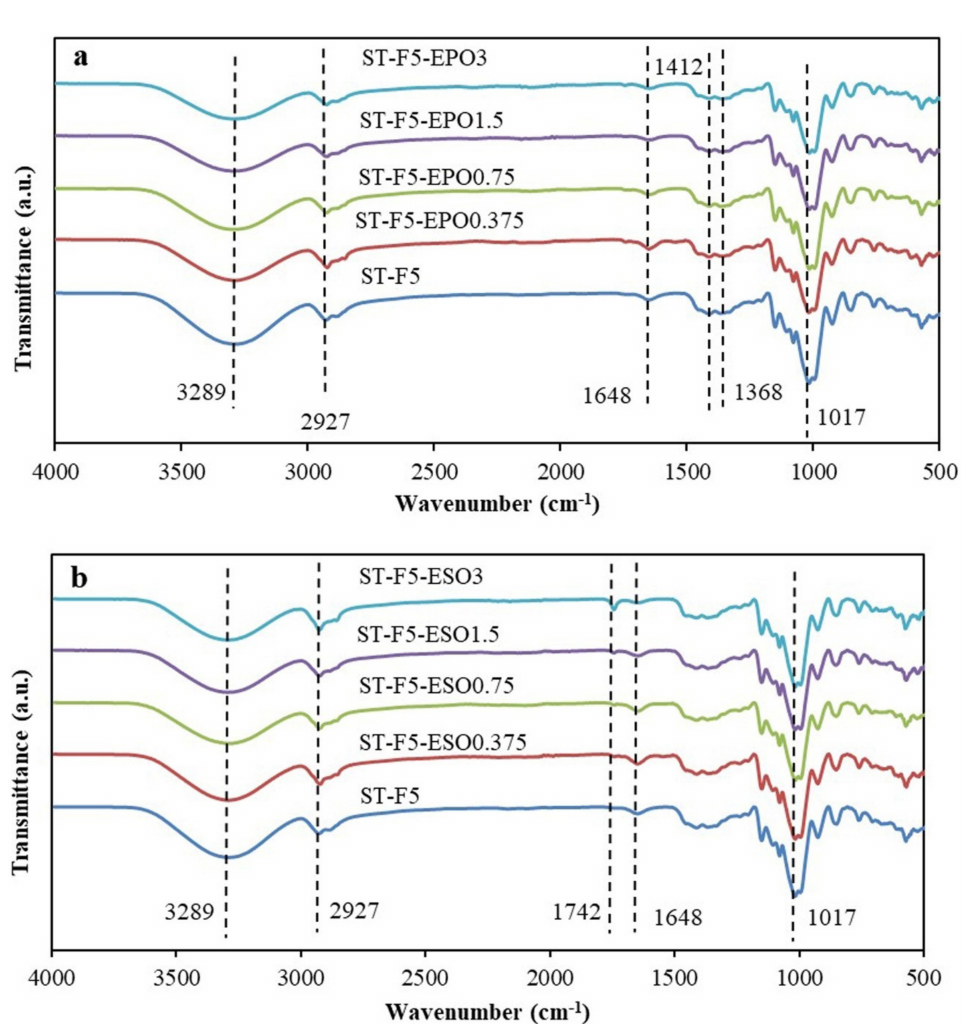
Figure 2. FTIR spectra of ( a ) bioplastic composites with EPO and ( b ) bioplastic composites with